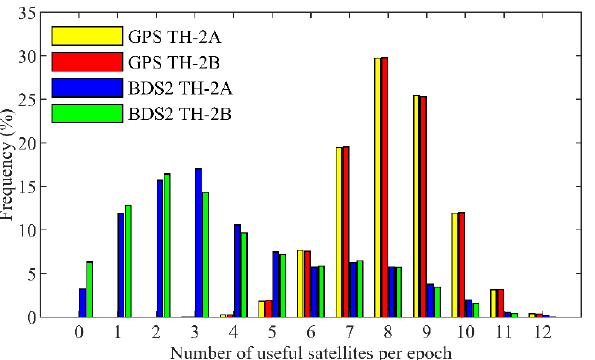
Figure 4. Statistics of the average number of available GPS and BDS2 satellites per epoch for TH ‐ 2A and TH ‐ 2B.